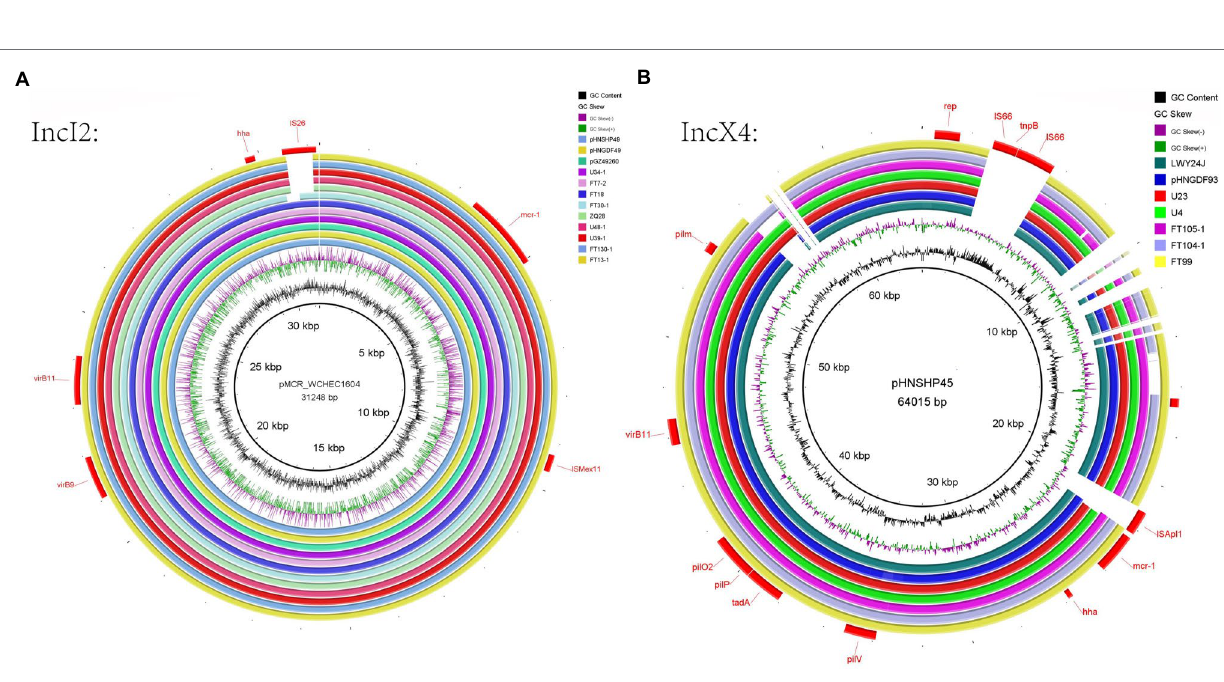
FIGURE 2 | IncI2 plasmid analysis for 21 MCRPEC isolates from migratory birds (A) . Alignments of IncI2 plasmids from this study with reference plasmid pHNSHP45. (B) Alignment of IncX4 plasmids with reference plasmid pMCR_WCHEC1604. The sources of these plasmids were migratory birds (FT7-2, FT18, FT13- 1, FT30-1, FT99, FT104-1, FT105-1, FT130-1, U4, U23, U34-1, U39-1, U48-1, and ZQ28), human plasmids (pMCR_WCHEC1604, pHNSHP45, and pGZ49260) and animals (pNFGDF93, pLWY24J, pNFGDF49, and